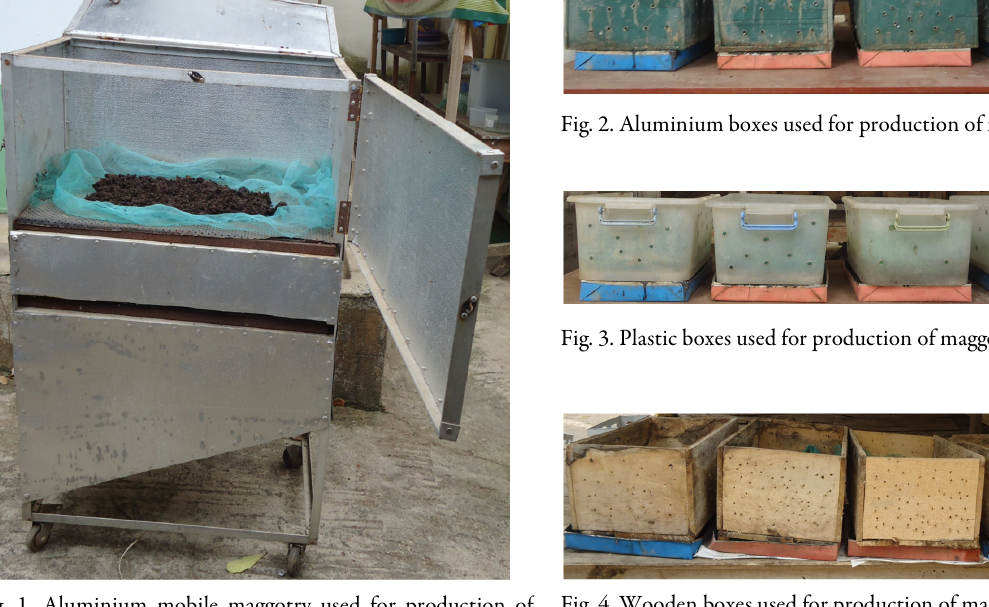
Fig. 1. Aluminium mobile maggotry used for production of maggots